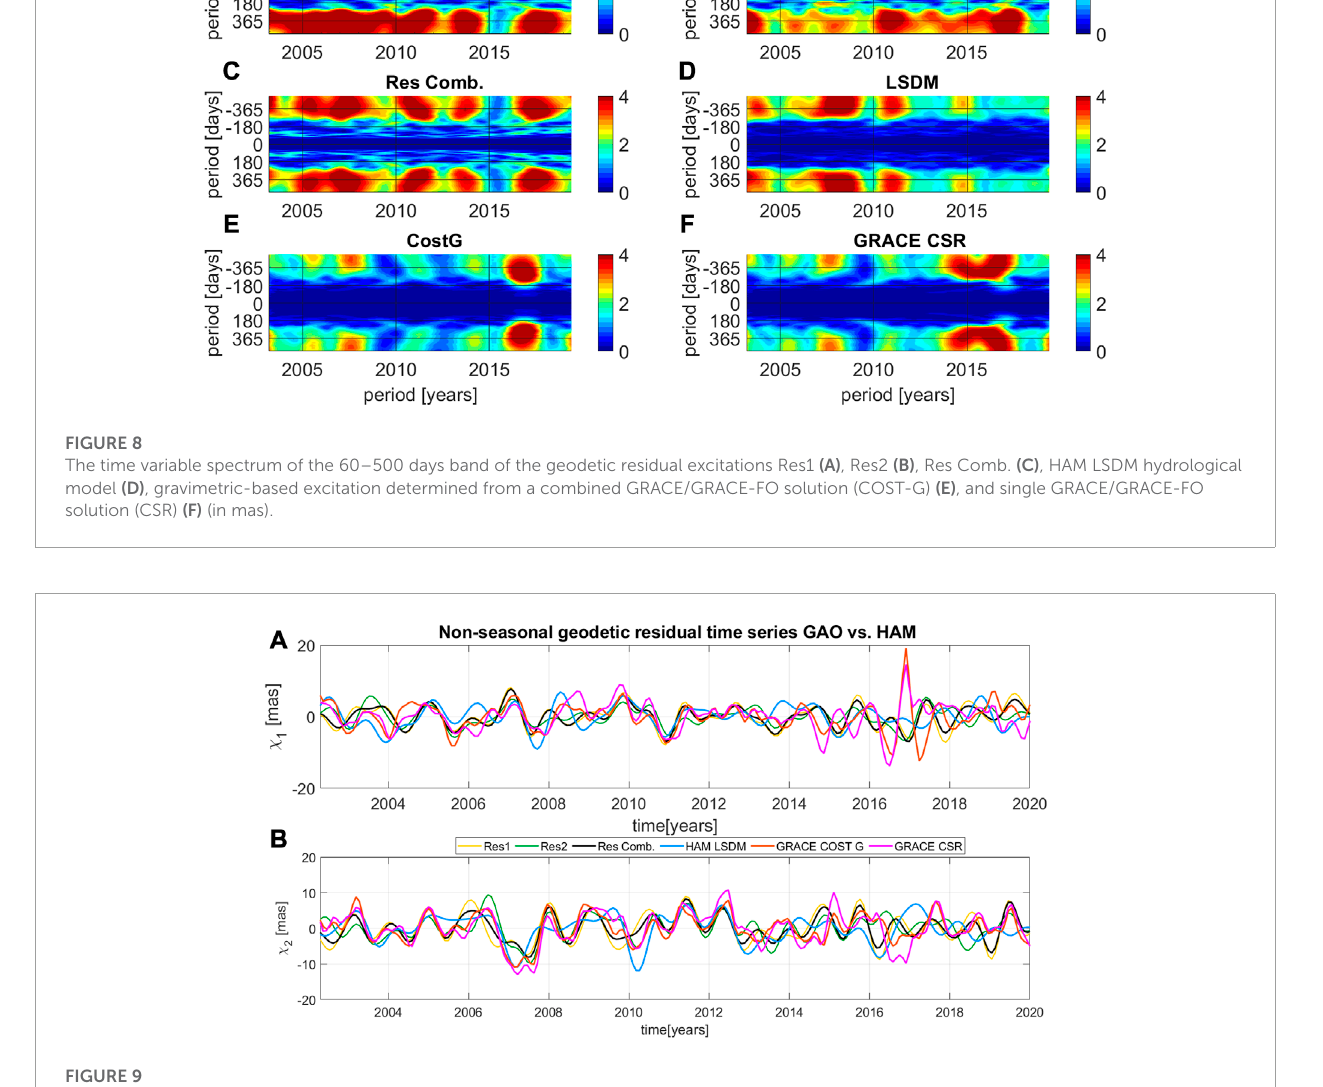
It can be seen that other geodetic residuals, Res1, and Res2, generally agree better with Res Comb. than GRACE and